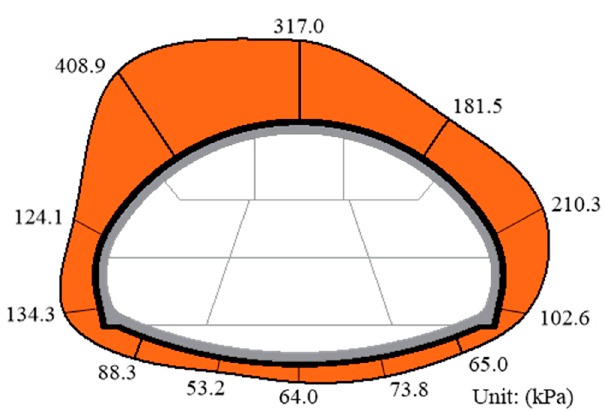
Figure 16. The final distribution of the contact pressure between the surrounding rock and the primary supports.